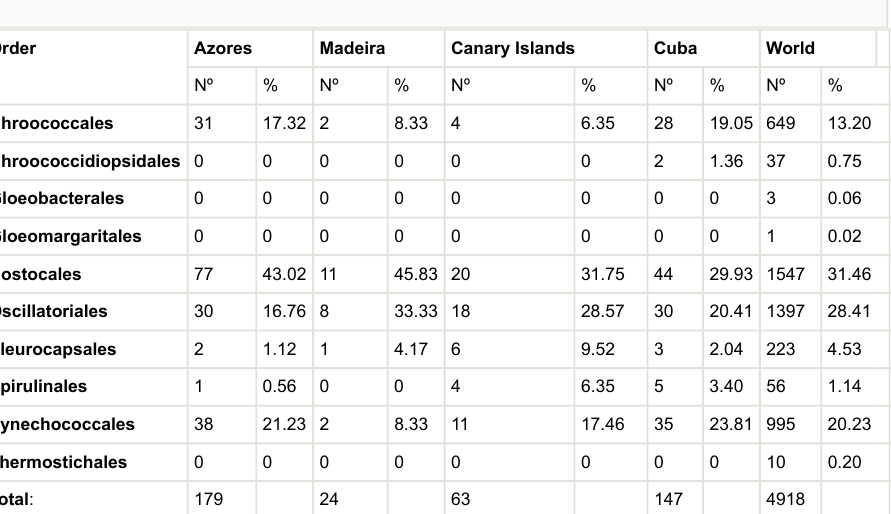
reports of new cyanobacteria in the Azores are expected to increase and the representation of the different orders can become similar to the global pattern.